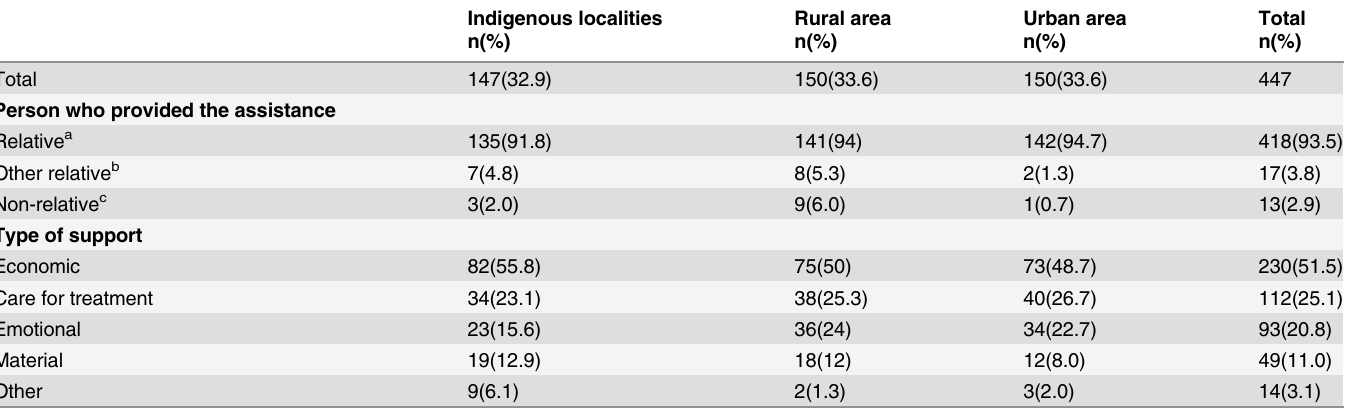
Table 4. Person who provided the assistance and type of support